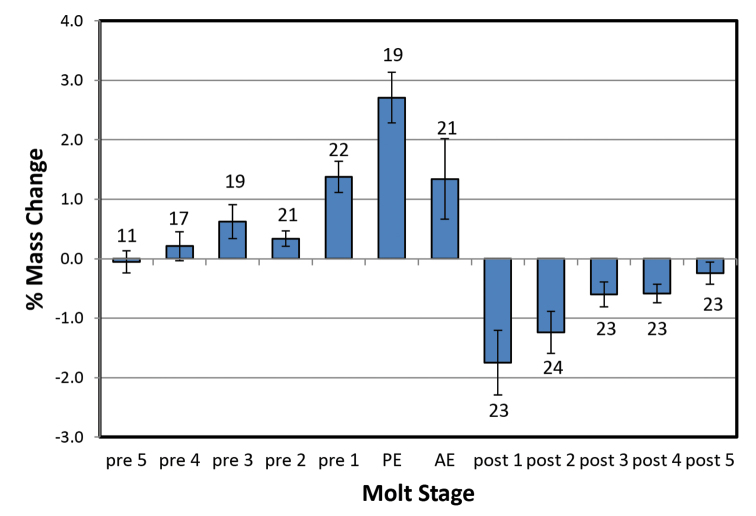
Mass changes of Porcelliodilatatus during molting at 100 % RH, without access to food. Bars show ± SEM with sample sizes.